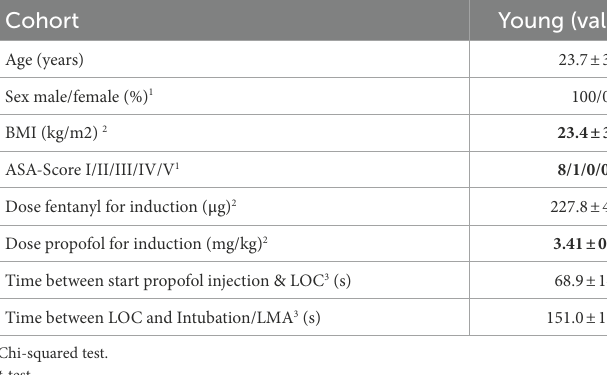
(Figure 3, right column). We computed group spectrograms of solely the periodic activity (Figure 2B, upper and middle panel). Most of the clusters of differences from the raw gamma, beta and alpha bands around LOC and a cluster